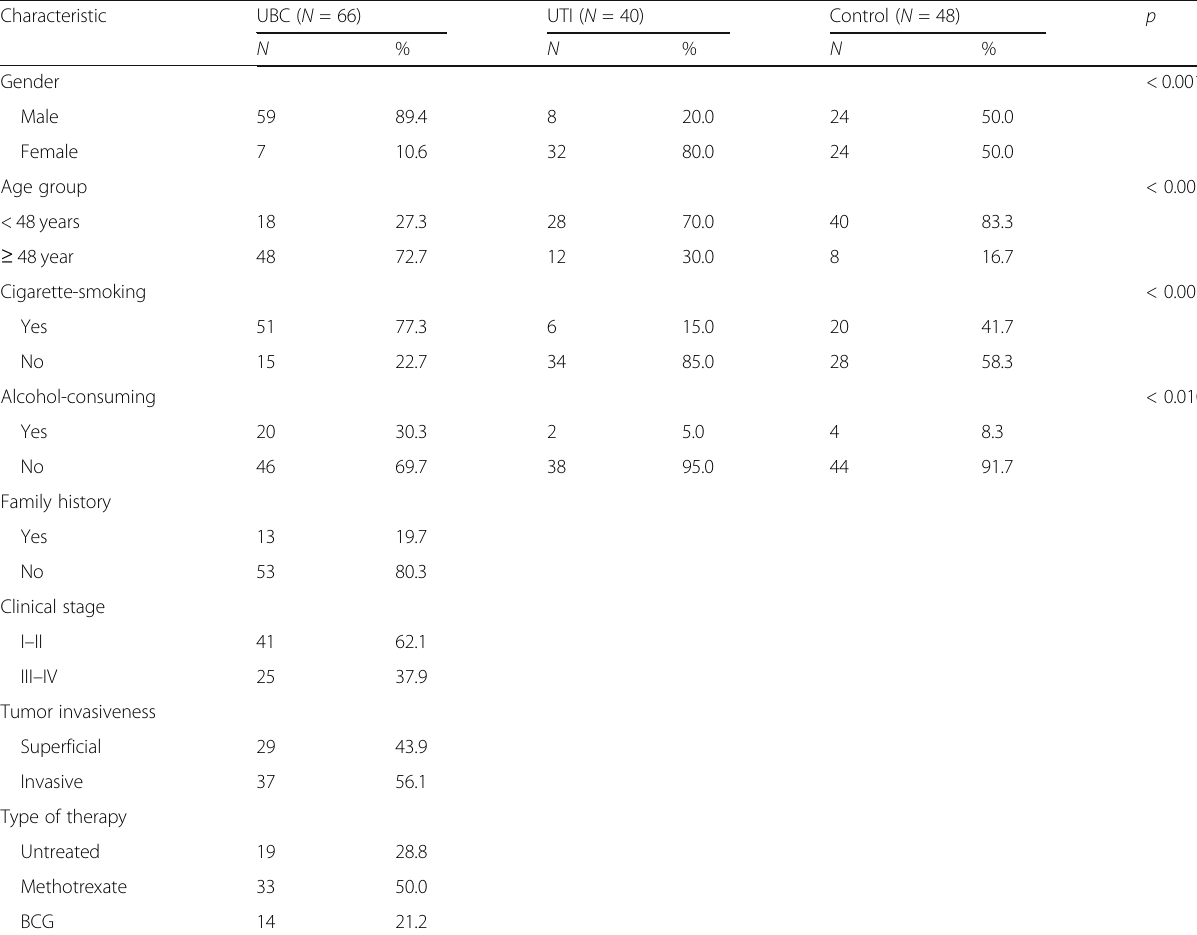
Table 1 Baseline characteristics of urinary bladder cancer and chronic urinary tract infection patients and control